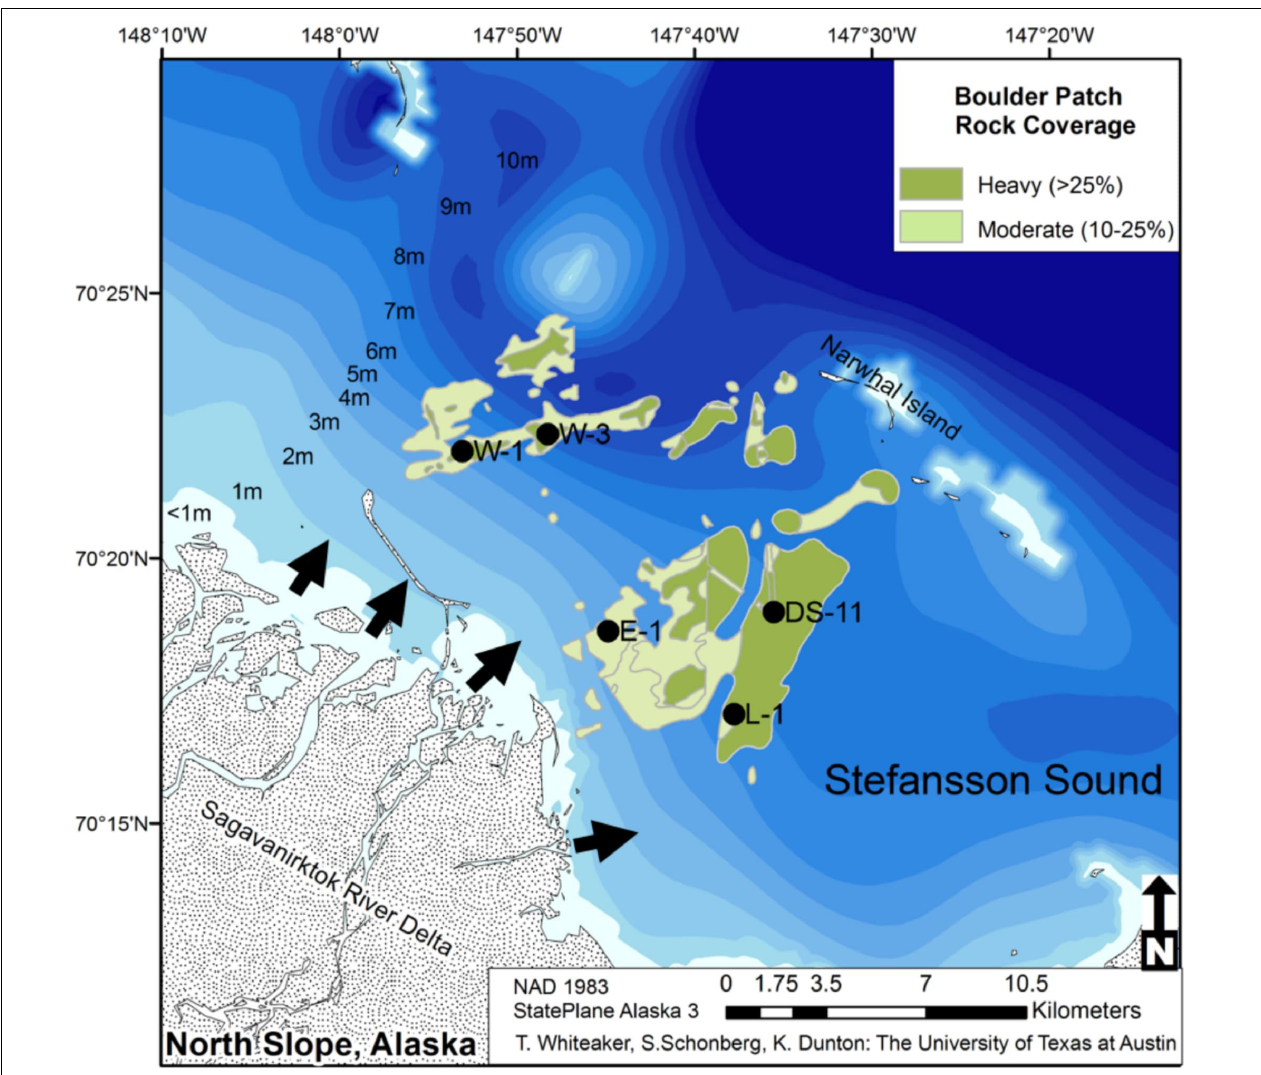
FIGURE 1 | Location of study sites (W1, W3, E1, L1, and DS11) in the Boulder Patch with rock cover indicated in green. Adapted from Bonsell and Dunton (2018). Arrows indicate channel inputs from the Sagavanirktok